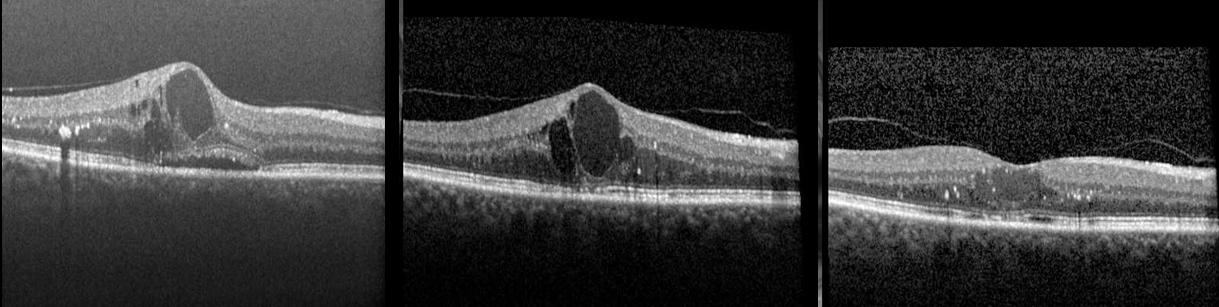
Figure 1. ( Left ) Patient with diabetic macular edema at baseline. The optical coherence tomography (OCT) exhibits hyperreflective foci, large cysts, subretinal fluid and a ganglion layer cyst. A vitre ‐ omacular adhesion is visible. Best ‐ corrected visual acuity (BCVA) is 20/50. ( Middle ) OCT 10 days after the seventh ranibizumab injection on a monthly basis. Hyperreflective foci have significantly decreased, but large intraretinal cysts have remained, partly with homogenous hyperreflective con ‐ tent; some disruption of the ellipsoid zone (EZ) is visible. BCVA remained at 20/50. ( Right ) Four weeks after switching the patient to an intravitreal dexamethasone implant. Central retinal thick ‐ ness and intraretinal cysts have significantly decreased. However, more hyperreflective foci are vis ‐ ible, the content of cystoid spaces is homogenously hyperreflective, and the EZ and the external limiting membrane is intact. BCVA has improved by one line to 20/40.